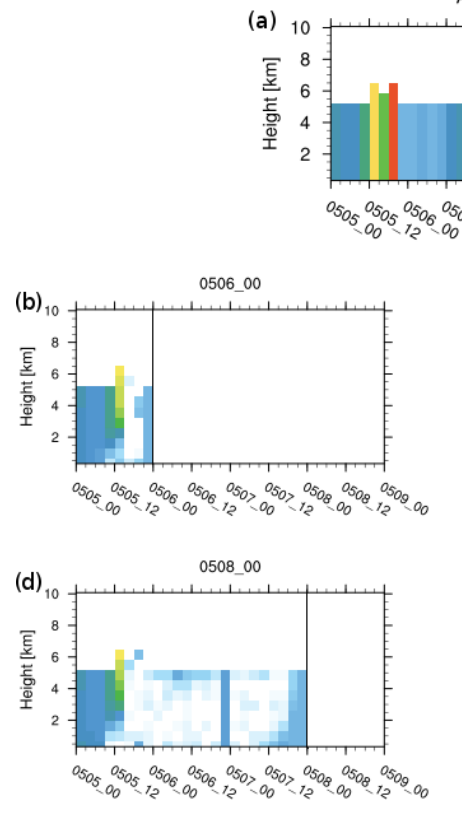
Figure 7. Same as Fig. 6 but for the May